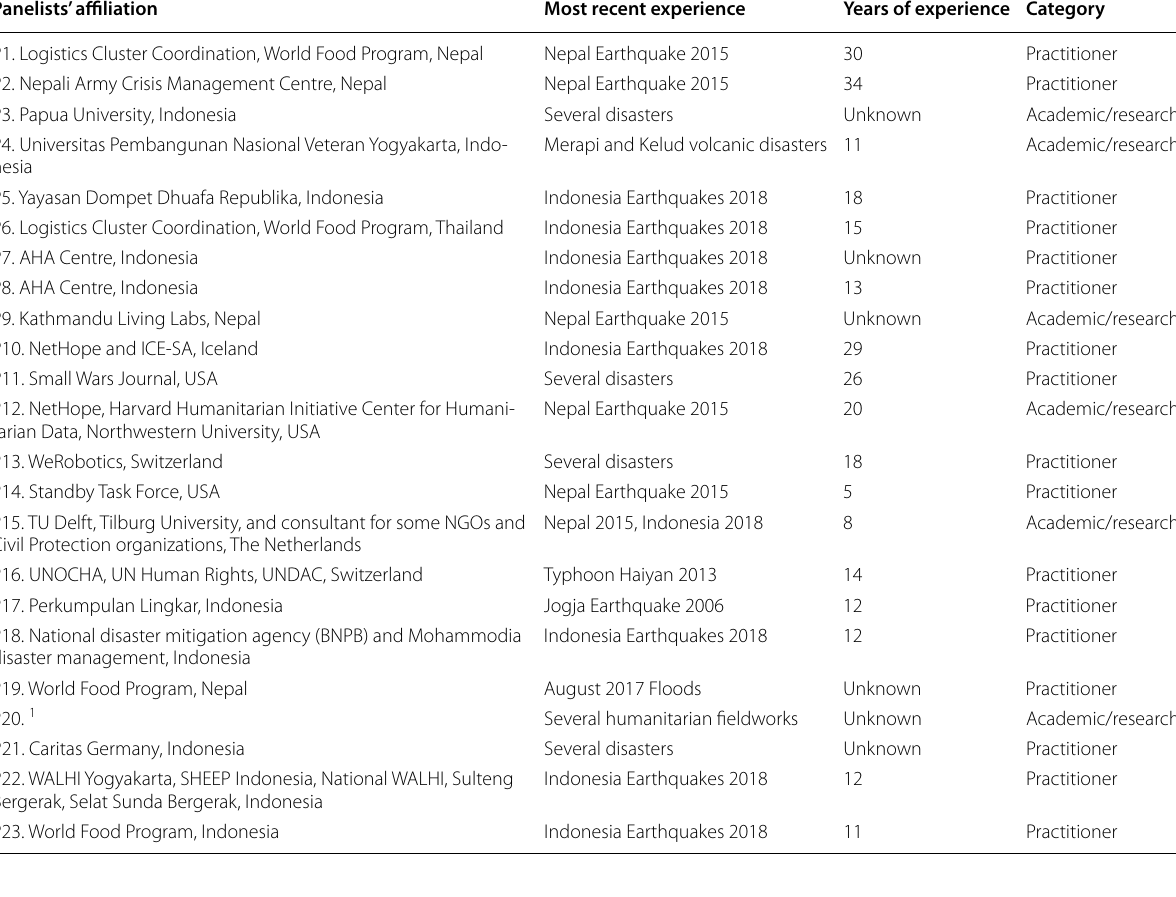
Table 4 The validating panel of the operational ecosystem Panelists’ affiliation